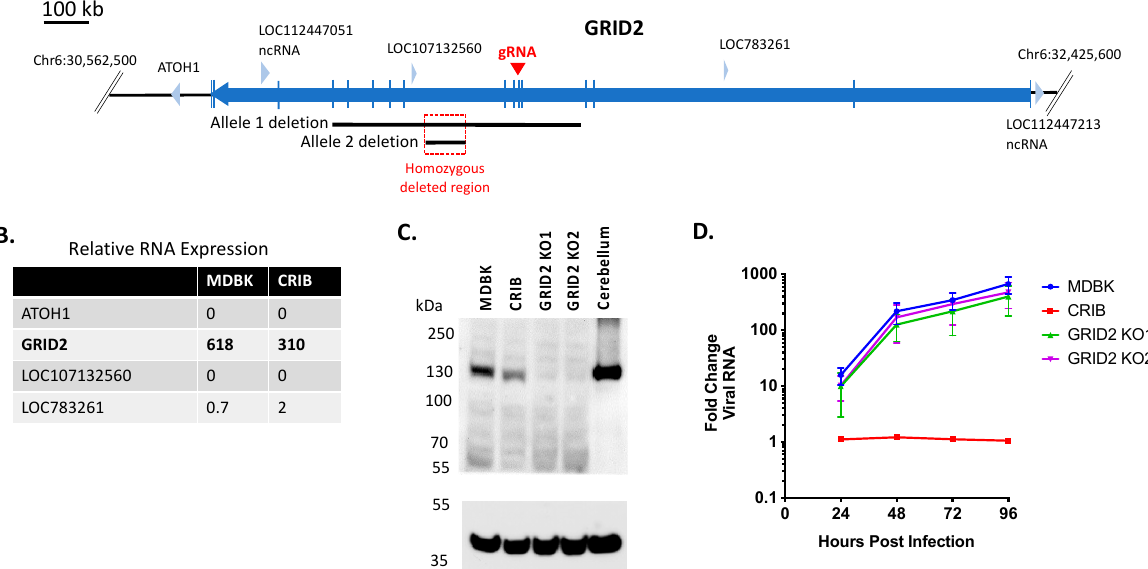
Figure 3. Knockout of GRID2 does not significantly impact BVDV infection in MDBK cells. Panel ( A ) map of bovine GRID2 and surrounding genes: blue arrows, genes (open reading frames); vertical blue lines, coding regions (exons); black lines, heterozygous deletions in two alleles of GRID2 on chromosome 6; red square, homozygous deleted region (63,200 bp); red arrow, exon target of GRID2 gRNA. Panel ( B ) Relative RNA expression levels in MDBK and CRIB cells (TMM normalization value). Pane ( C ) western blot of SDS-PAGE for GRID2 and GAPDH (loading control). Bovine cerebellum was used as a positive control for GRID2 expression. Panel ( D ) Multistep virus growth curve. Cells were infected with BVDV strain NADL (MOI 0.01). Cells were collected and processed 0–96 h post-infection for quantitation of viral RNA using RT-qPCR. Results represent the mean ± standard deviation ( n = 3).